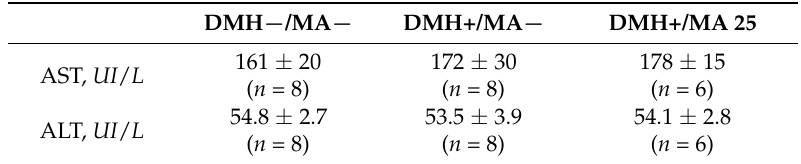
Figure 5. Mucin depleted foci (MDF) assessed after dying the colon with high-iron diamine/alcian blue/neutral red staining (HID-AB) and analyzed under a light microscope (magnification of × 10). Topographic features of the colonic epithelium of animals in ( A ) the negative control (DMH − /MA − ) and the positive control (DMH+/MA − ) displaying ACF with one ( B ) or two ( D ) crypts and MDF with one ( C ) or two crypts ( E ). The effects of maslinic acid at the doses of 0, 5, 10 and 25 mg/kg on the number of MDF in ( F ) total colon; ( G ) colonic segments and ( H ) number of crypt devoid of mucin per focus in total colon. Results are expressed as mean ± SEM and were analyzed by the non-parametric Kruskal–Wallis test, followed by Dunn’s multiple comparisons test, n = 6–8. Asterisks indicate different from the control group: * p < 0.05. Table 1. Hepatic enzymes in animals in the negative control group, positive control group and injected with DMH and MA at 25 mg/kg treatment group 1